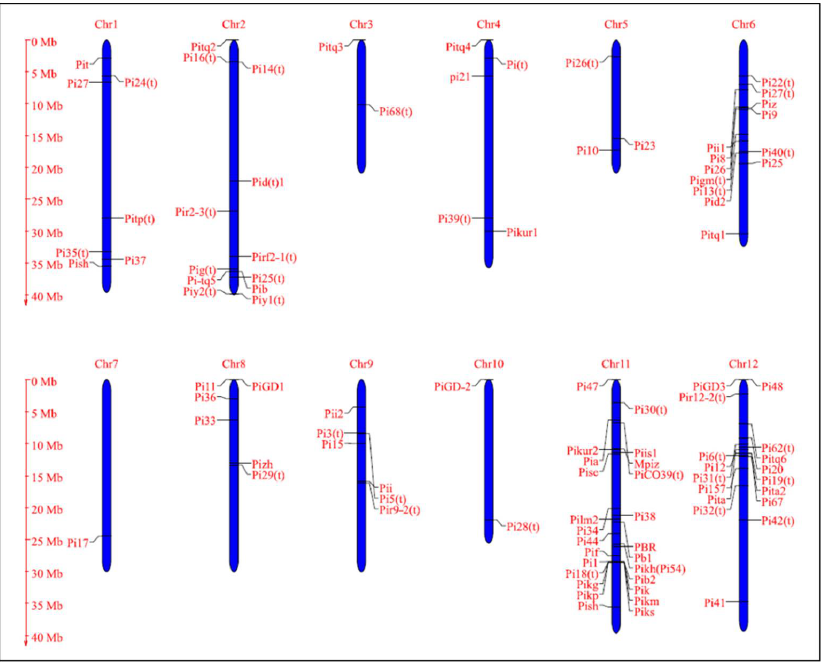
Figure 6. Rice blast resistance genes identified and mapped on to different rice chromosomes.